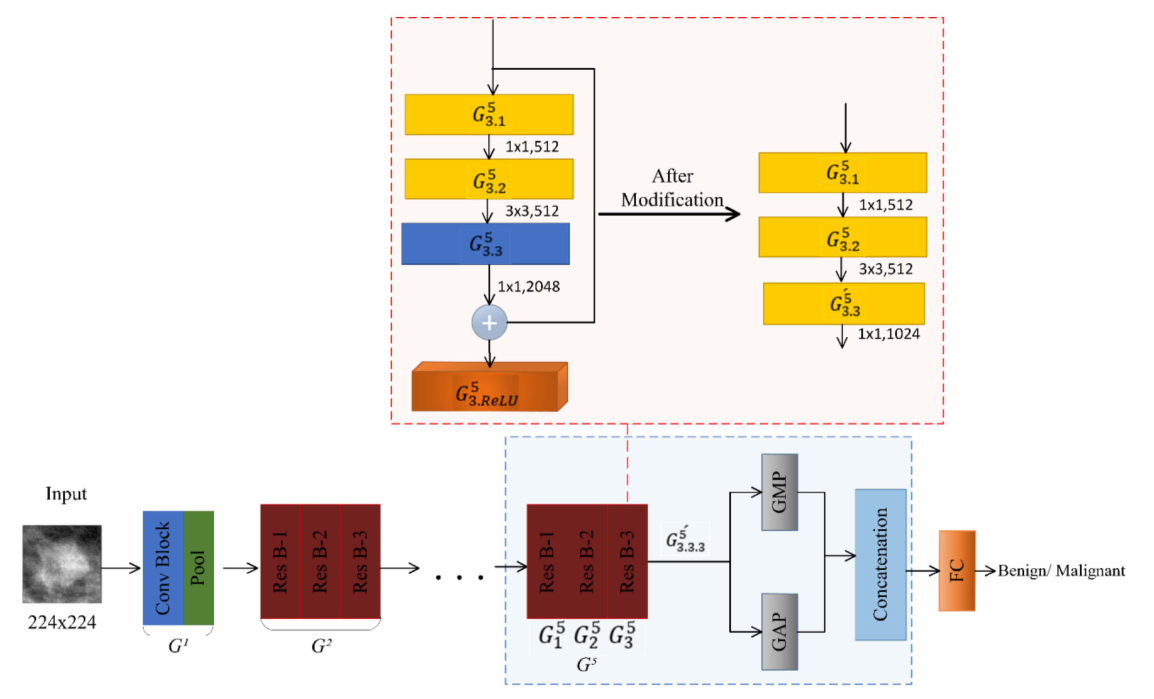
Figure 9. DIVResNet-50